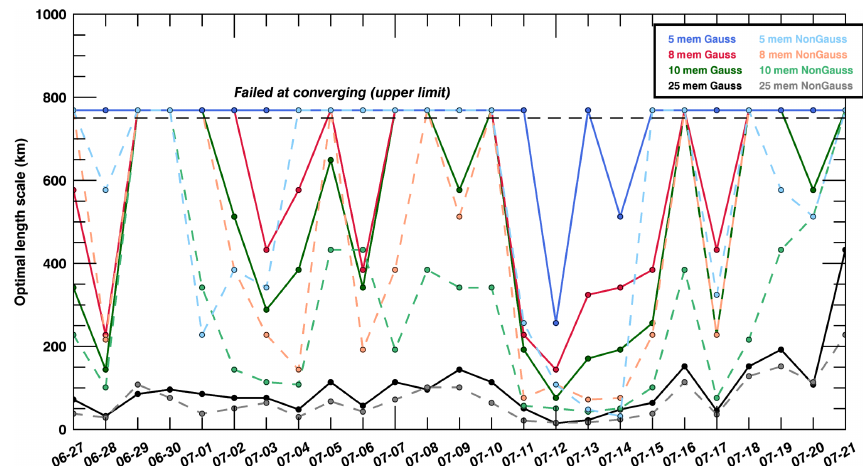
Figure 4. Length scale (in km) of the variance filter for planetary boundary layer heights using Gaussian (solid lines) and non-Gaussian (dash lines) equations from 27 June to 21 July 2008.